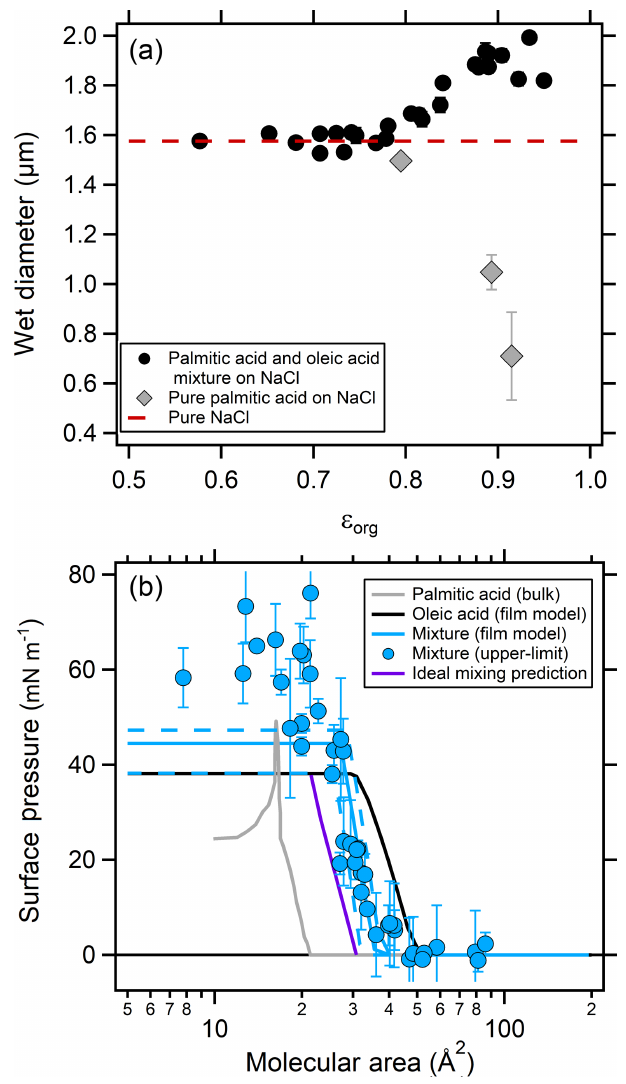
Figure 4. (a) Measured wet diameter at RH = 99.88% as a func- tion of organic volume fraction for 200nm NaCl particles coated with pure palmitic acid (diamonds) and a mixture of palmitic acid and oleic acid (triangles). (b) Upper-limit and film model estimates for NaCl particles coated with a mixture of oleic acid and palmitic acid surface pressure as a function of molecular area. The black line is the oleic acid film model estimate and the grey line corre- sponds to macroscopic surface pressure measurements from Tang et al. (2010), since surface pressure measurements for NaCl parti- cles coated with pure palmitic acid were not possible (see text for details). The purple line is the ideal mixing estimate for surface pressure based on the measured molar fractions of oleic acid and palmitic